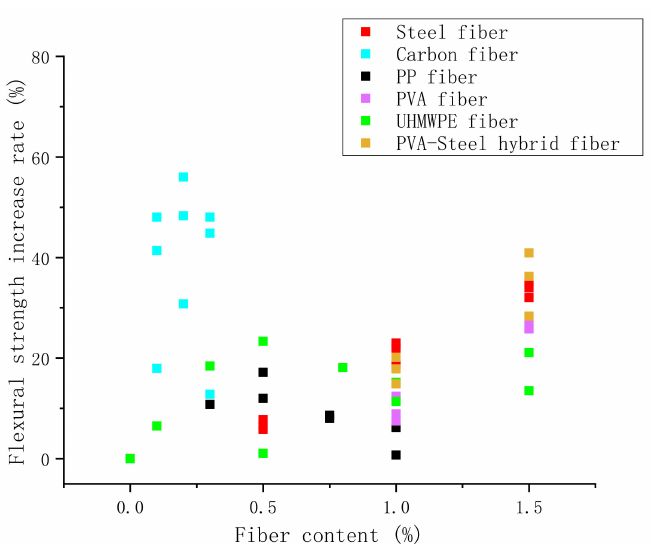
Figure 8. Effect of fiber types and content on the flexural strength of RAC: Steel fiber [64]; Carbon fiber [65]; PP fiber [67]; PVA fiber [79]; UHMWPE fiber [70,90]; PVA-Steel hybrid fiber